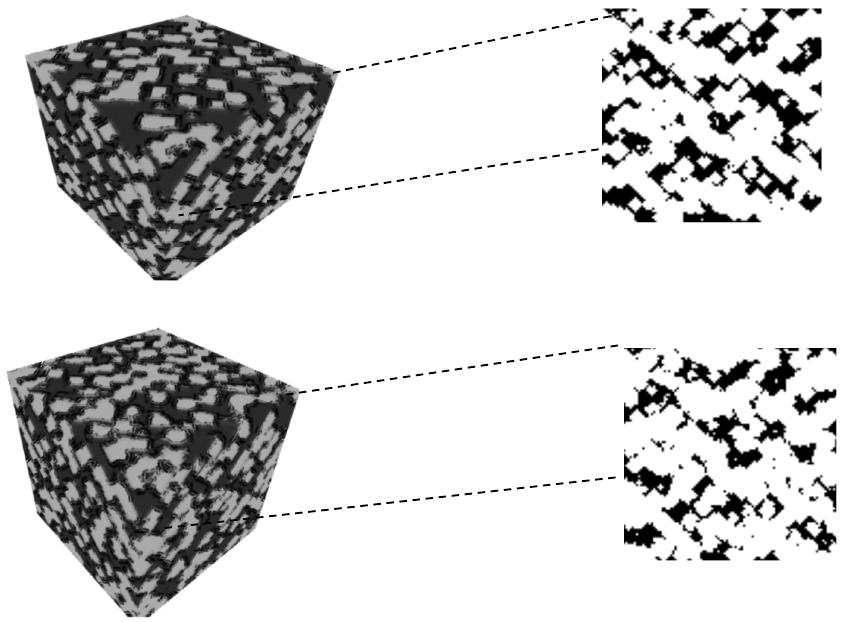
Figure 6. 3D visualization for tungstan–30% copper with 100 voxels and different input variables.